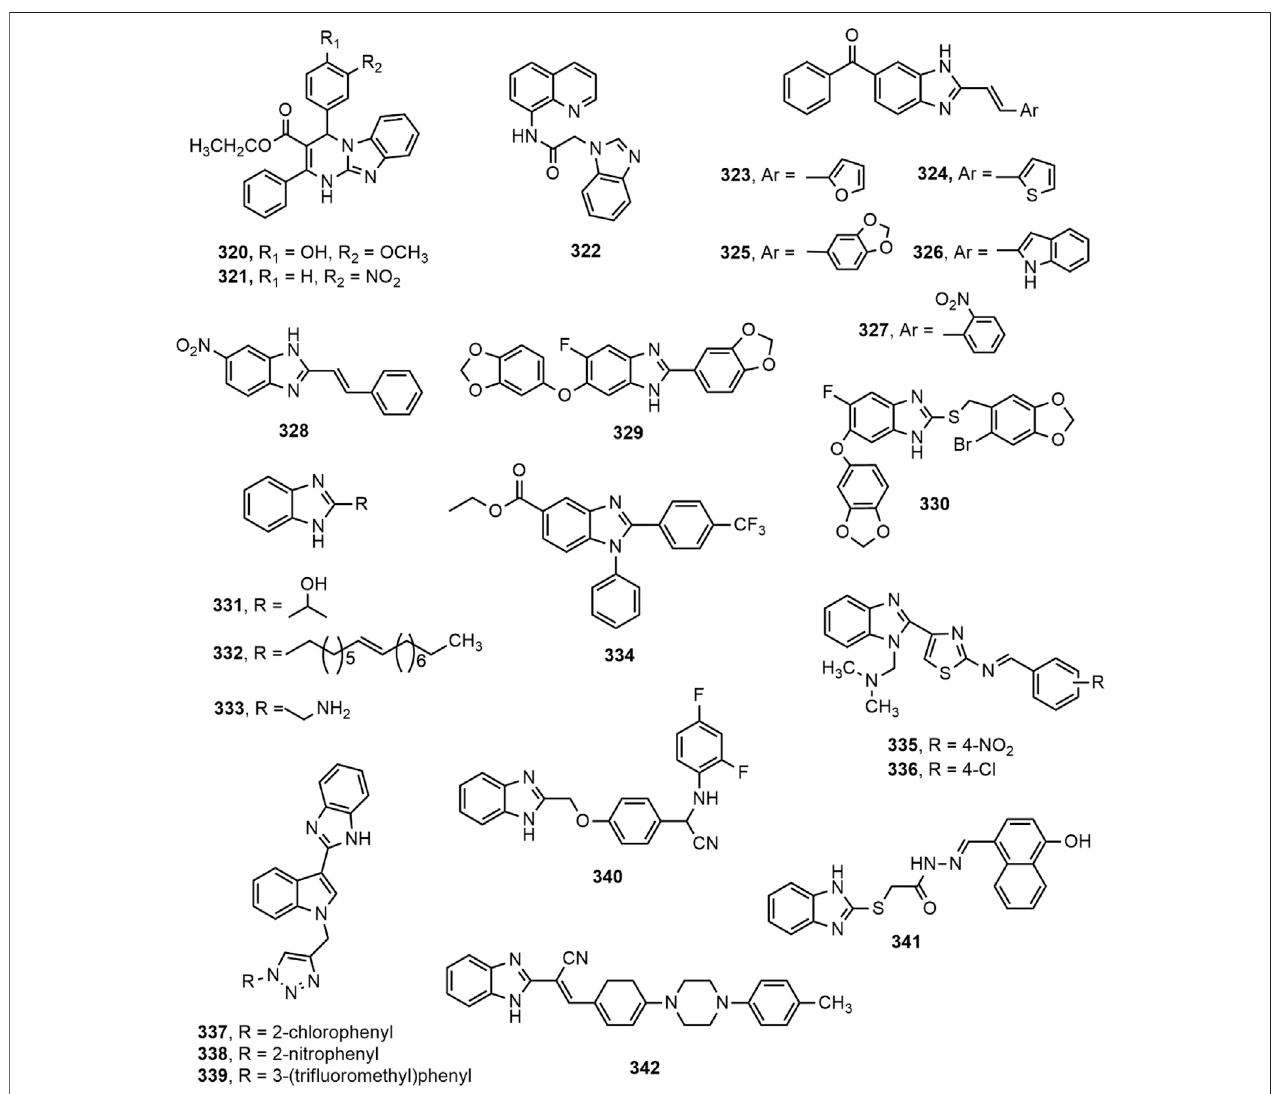
FIGURE 12 | Benzimidazole derivatives with antitubercular